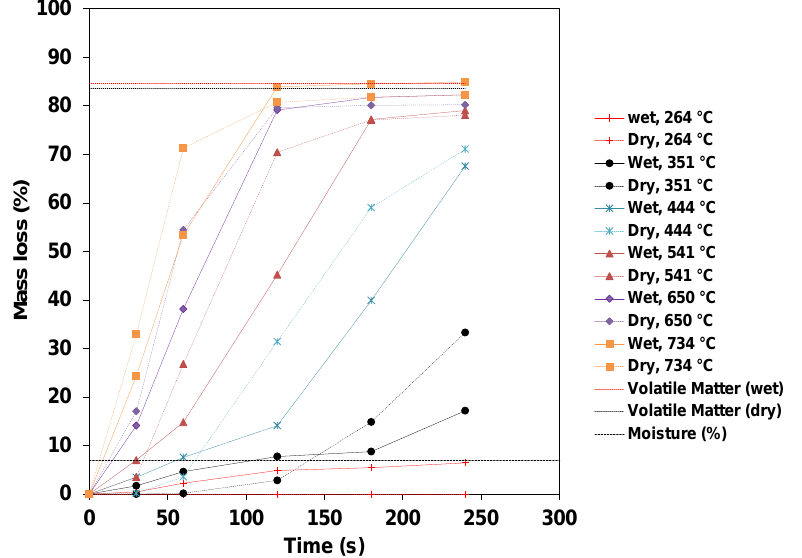
Figure 3. Mass loss of dry and wet pellets.